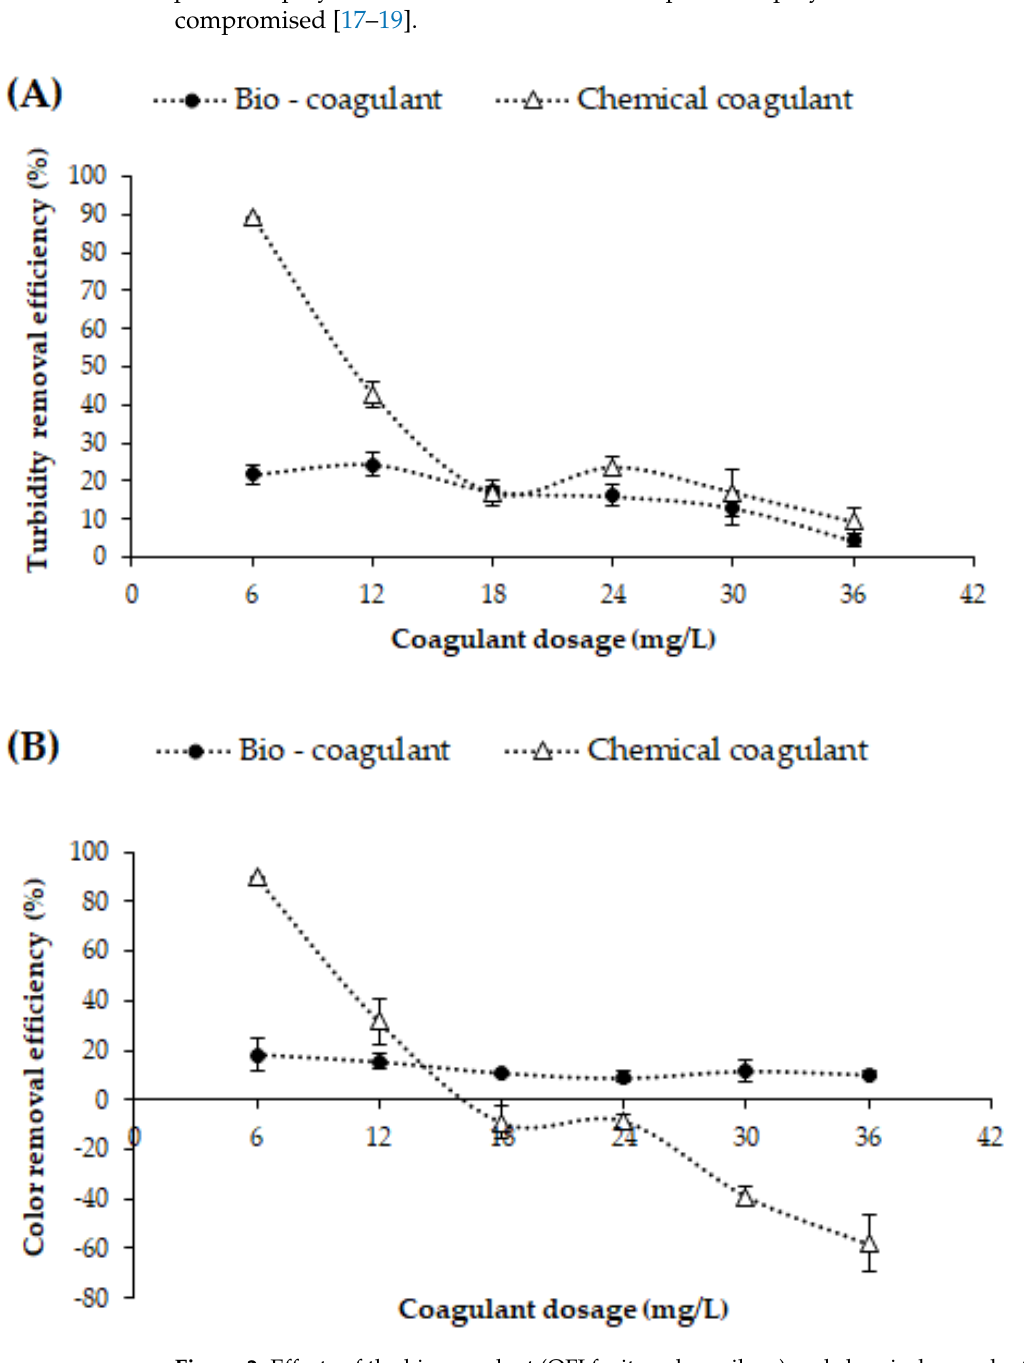
Figure 2. Effects of the biocoagulant (OFI fruit peel mucilage) and chemical coagulant (FeCl 3 ) dose on the turbidity-removal efficiency (%) ( A ) and the color-removal efficiency (%) ( B ) at an adjusted pH of 7.85 ± 0.09.